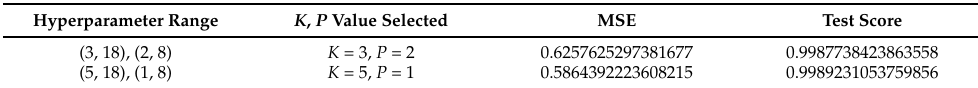
Table 7. Comparison of results for different values of K and P .